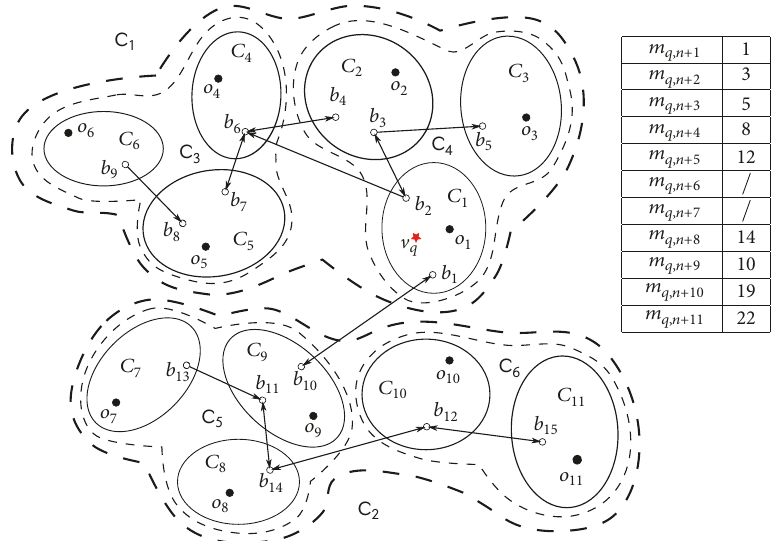
Figure 3: A 2 -Partition on a voronoi-based index.